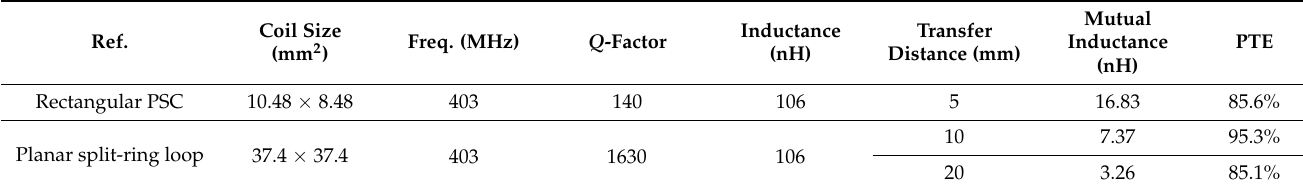
Table 3. The comparison between this proposed split-ring loop and the conventional rectangular PSC. Ref.